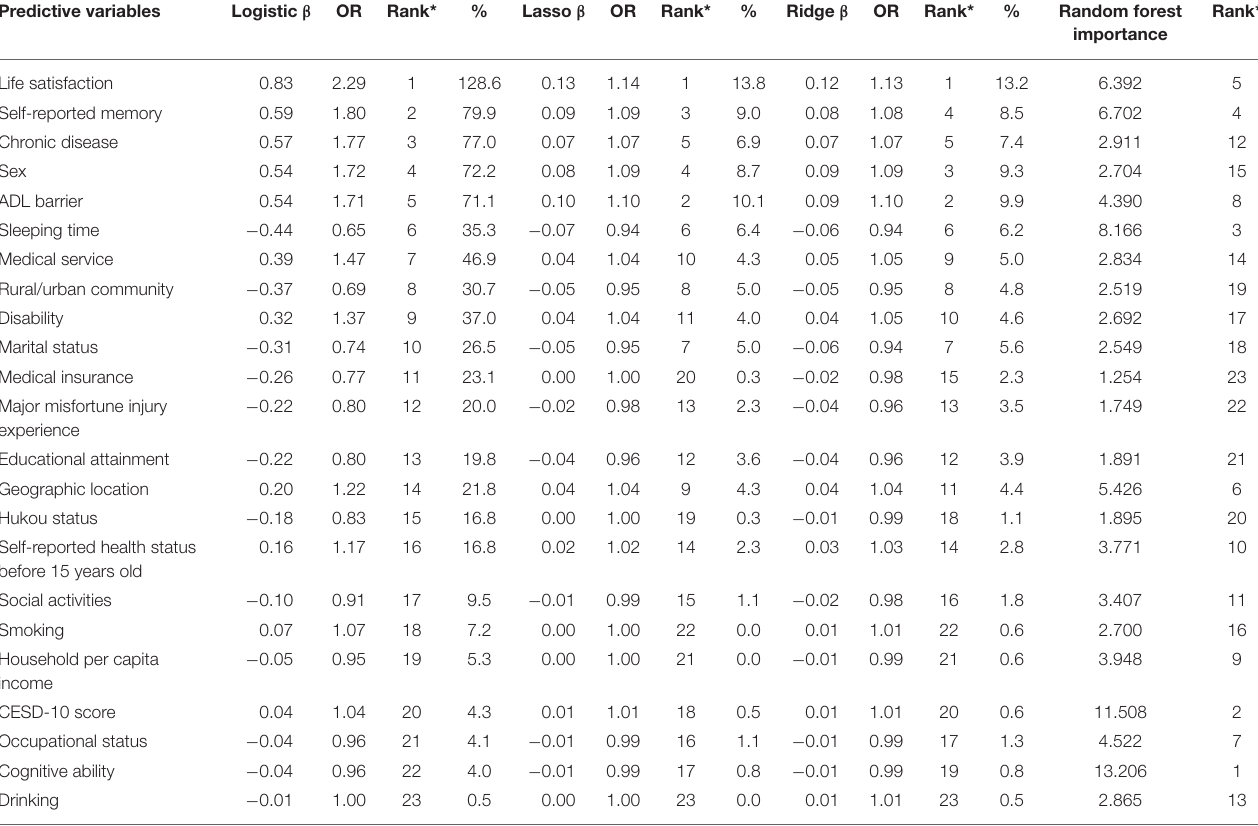
TABLE 3 | Overview of the decreasing importance of the 23 baseline predictors for each prediction model. Predictive variables Logistic β OR Rank* % Lasso β OR Rank* % Ridge β OR Rank* % Random forest